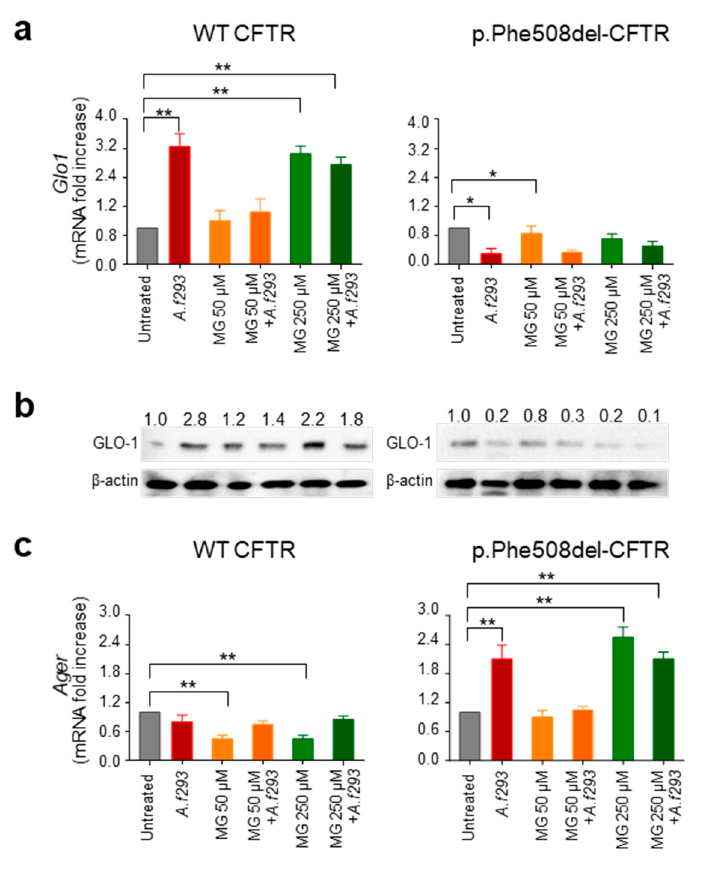
Figure 2. GLO1 is down-regulated in CF bronchial cells exposed to A. fumigatus conidia. CFBE41o- cells transduced with either wild-type or p.Phe508del-CFTR were treated with A. fumigatus conidia and/or methylglyoxal (MG) for 8 h and evaluated for ( a ) GLO1 mRNA and ( b ) protein levels, and ( c ) Ager mRNA levels. Protein levels were determined by Western blot analysis, and gene expression by RT-PCR. In panel b, numbers indicate intensity ratio. Data are presented as mean ± SD of three independent experiments. * p < 0.05, ** p < 0.01, treated vs. untreated.